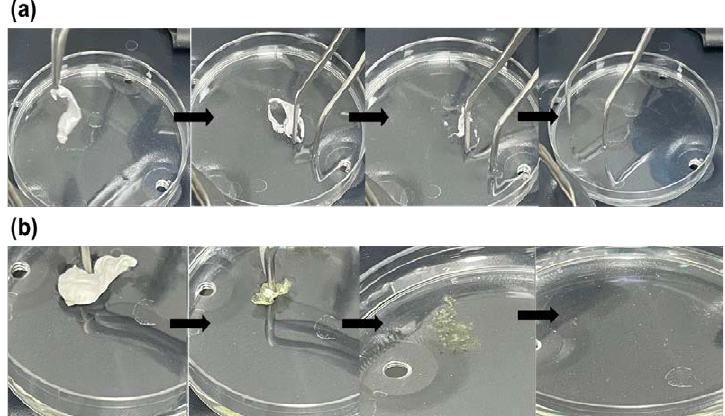
Figure 5. The disintegration of ( a ) blank fibers and ( b ) drug-loaded fibers shows that the blank fiber disintegrated and dissolved more rapidly (≤2 s) than the drug-loaded fibers (≤12 s). The yellow color in the drug-loaded nanofibers indicates the encapsulation of nifedipine.